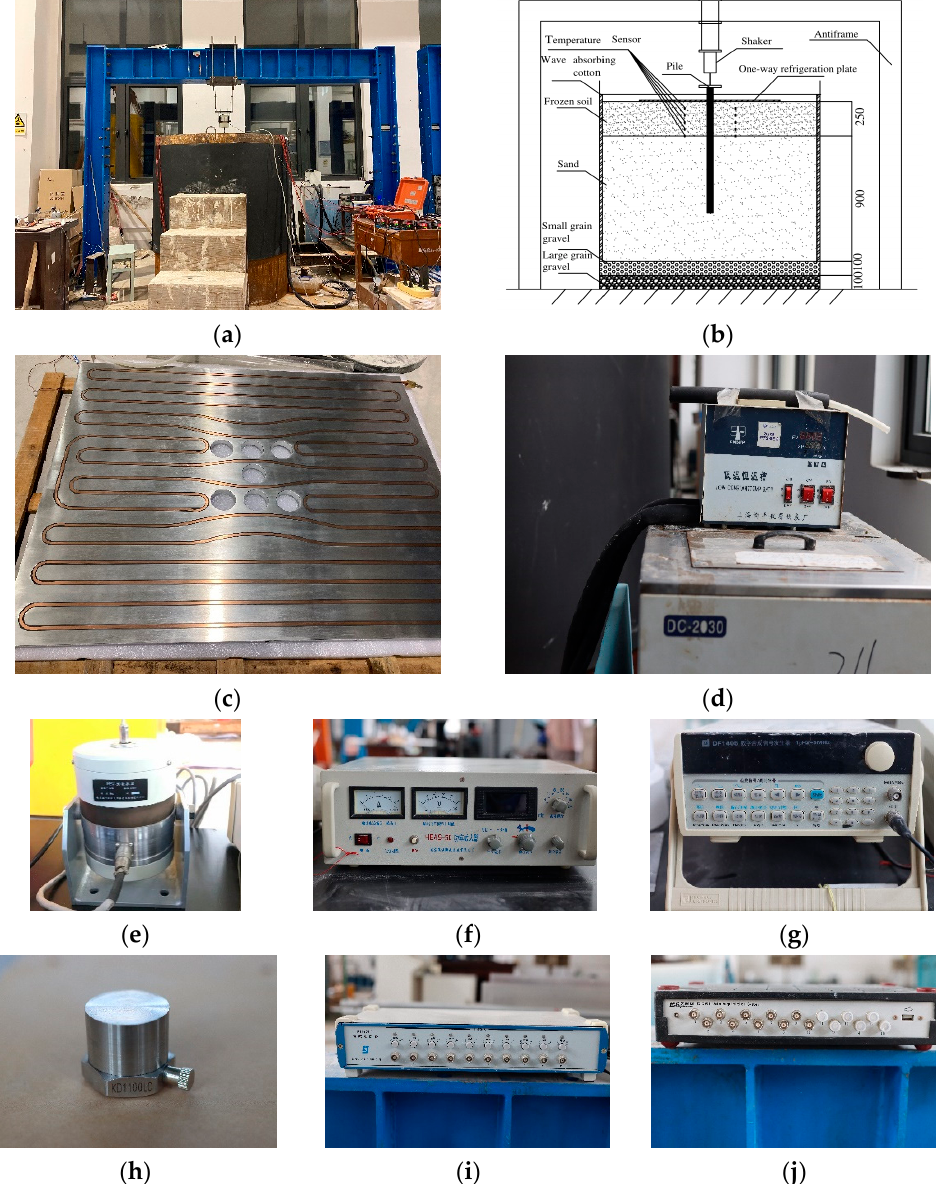
Figure 3. Schematic diagram of the artificial frozen experimental system for the model pile tests. ( a ) Model box; ( b ) schematic diagram of the model test; ( c ) one-way refrigeration plate; ( d ) DC-2030 refrigeration compressor; ( e ) shaker; ( f ) HEAS-50 power amplifier; ( g ) DF1405 digital; ( h ) KD1100LC